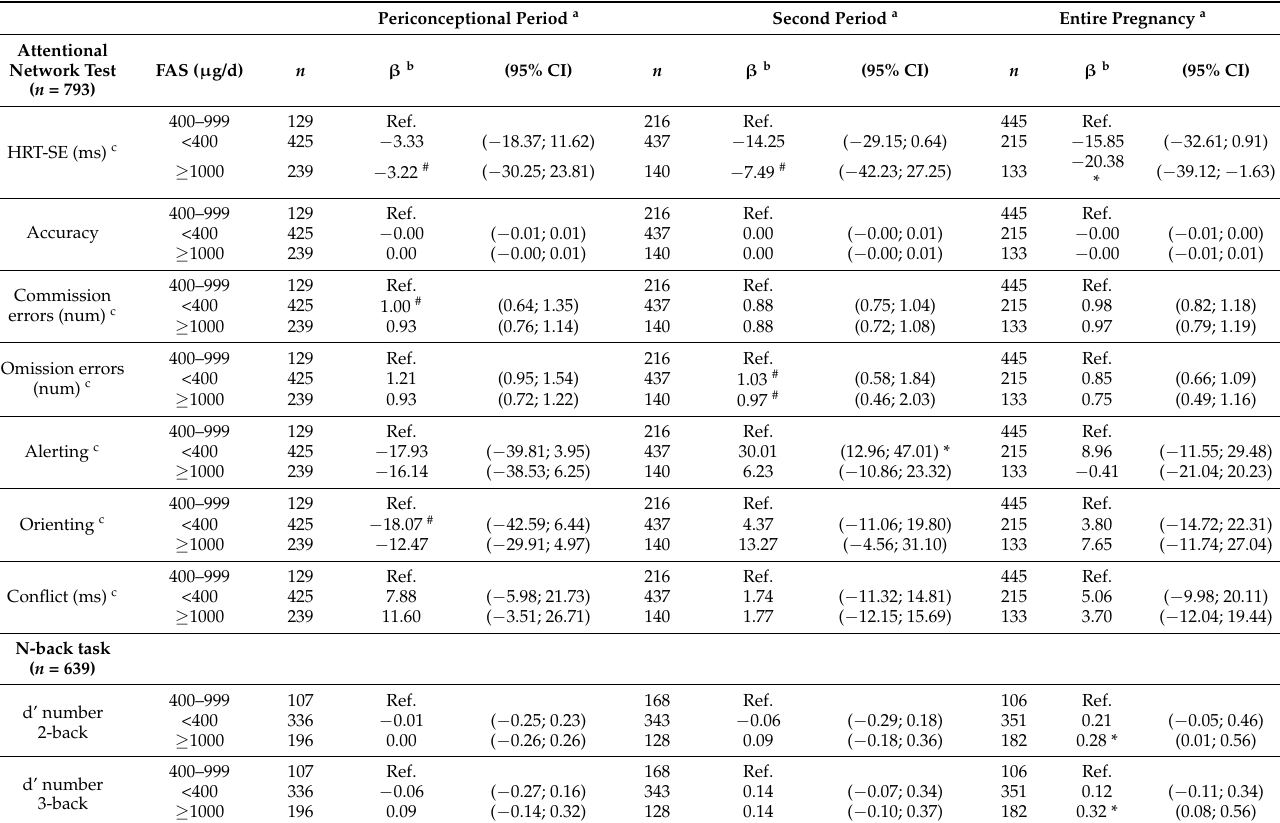
Table 3. Fully adjusted combined association between folic acid supplements (FAs) intake